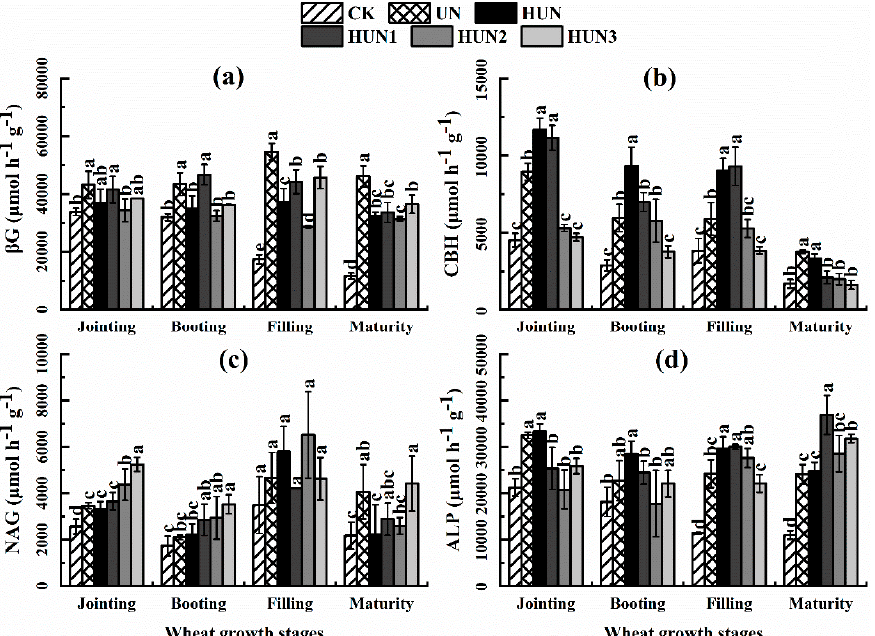
Figure 6. Effects of different treatments on β G ( a ), CBH ( b ), NAG ( c ) and ALP ( d ) in wheat growth stages. The lengths of the bars are average values. The length of the error bars is the standard deviation. Different letters indicate significant differences between different treatments at p < 0.05 for the same wheat growth stages. β G: β -1,4-glucosidase. CBH: β -D-1,4-cellobiosidase. NAG: β -1,4-N-acetyl-glucosaminidase. ALP: alkaline phosphatase. CK: no nitrogen. UN: urea, 240 kg N hm − 2 . HUN: humic acid urea, 240 kg N hm − 2 . HUN1: humic acid urea, 216 kg N hm − 2 . HUN2: humic acid urea,